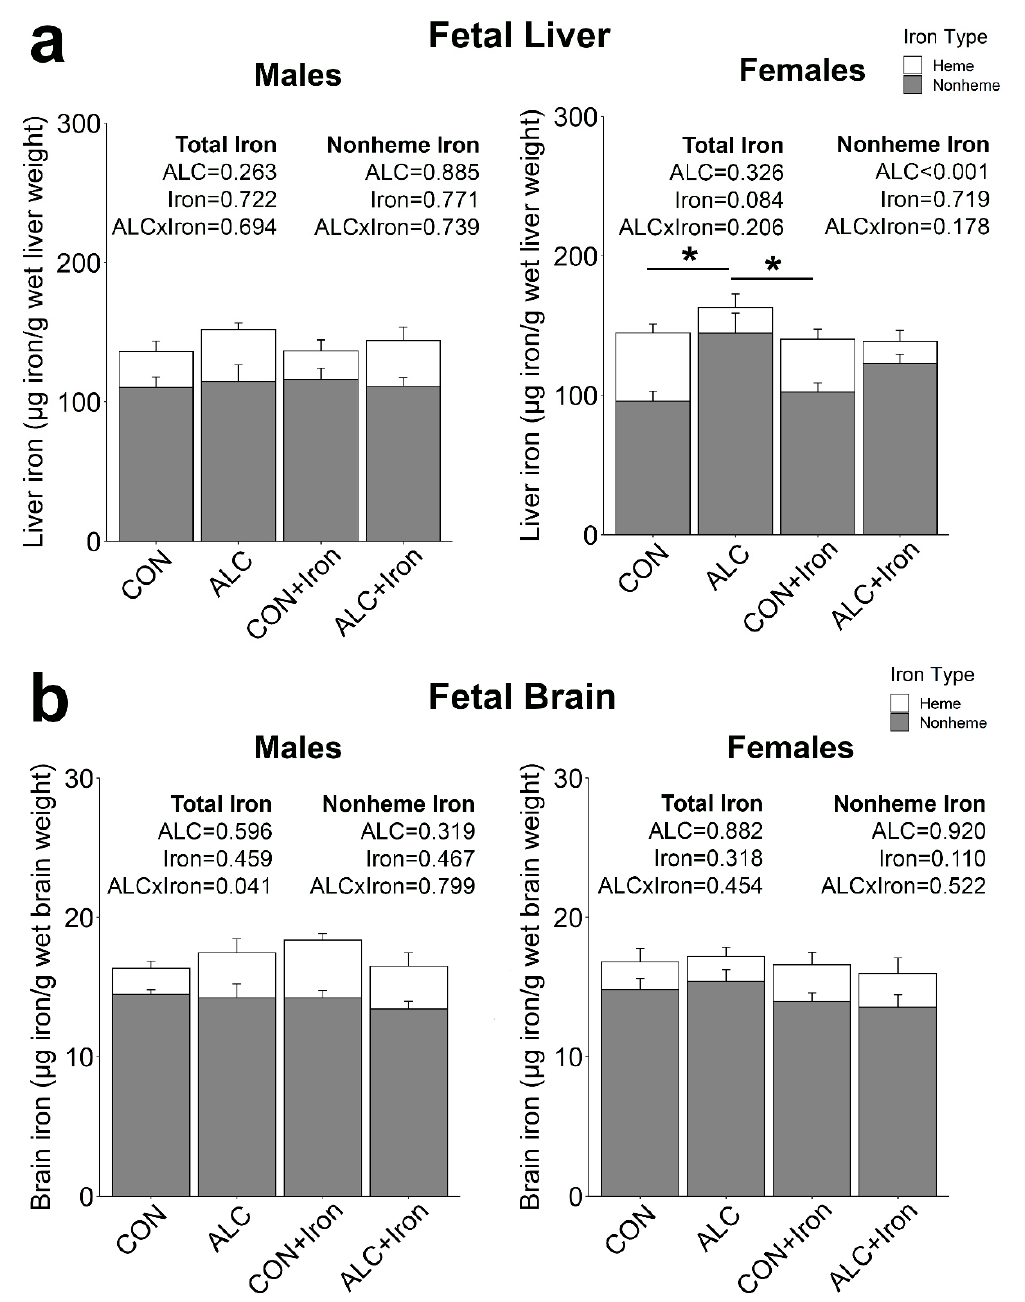
Figure 5. Alcohol exposure increased the iron content of female, but not male, fetal livers. Total and nonheme iron were quantified in fetal livers ( a ) and fetal brains ( b ) at gestational day 20.5. Bars represent means ± SEM. * p < 0.05. ALC, alcohol exposed; CON, control.